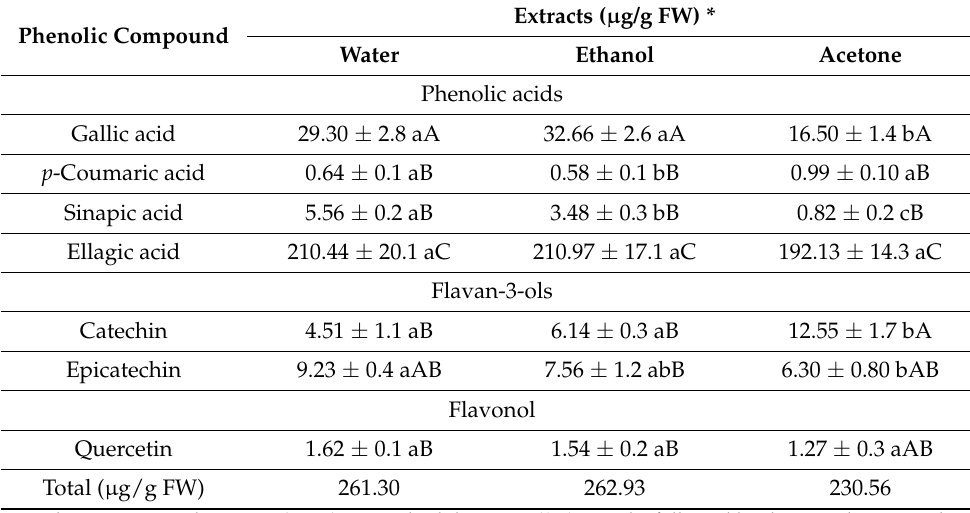
Table 2. Phenolic compounds in jua pulp extracts obtained upon ultrasound-assisted extraction. Extracts ( µ g/g FW) * Phenolic Compound Water Ethanol Acetone Phenolic